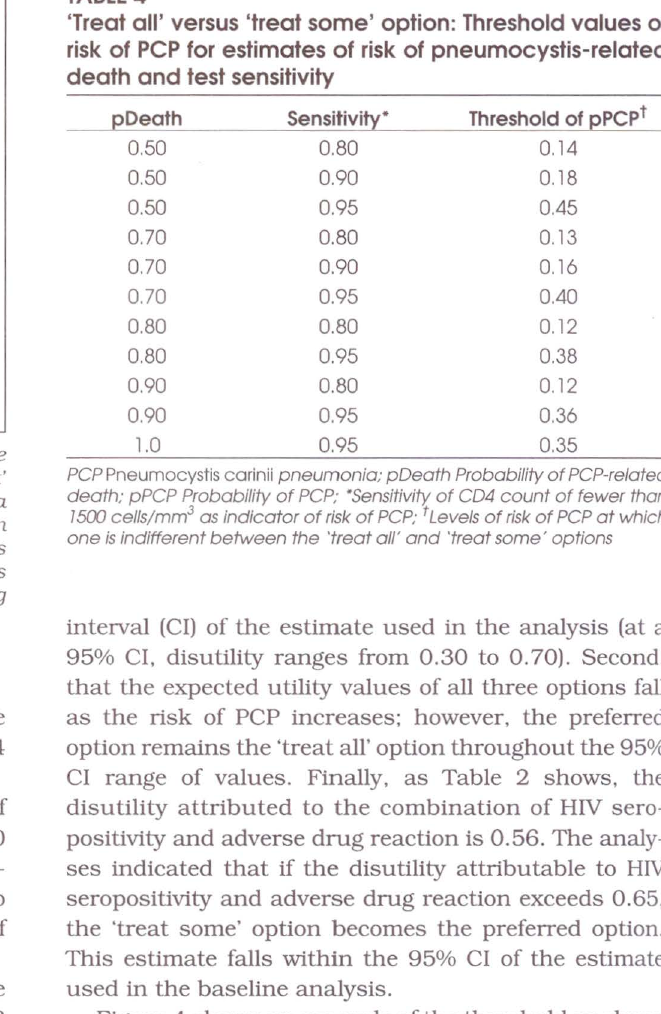
'Treat all' versus 'treat some' option: Threshold values of risk of PCP for estimates of risk of pneumocystis-related death and test